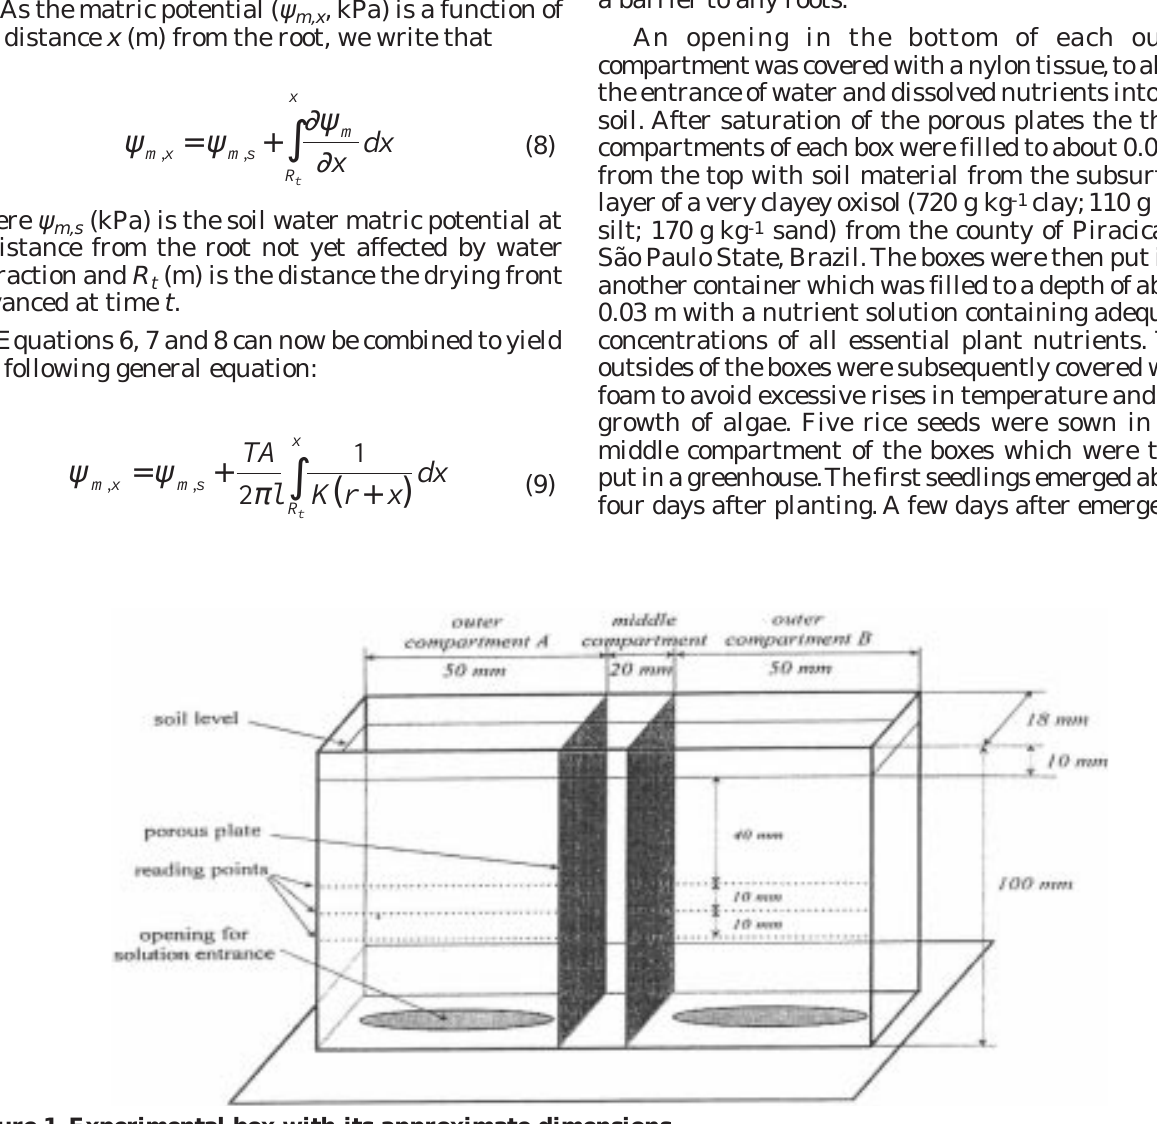
Figure 1. Experimental box with its approximate